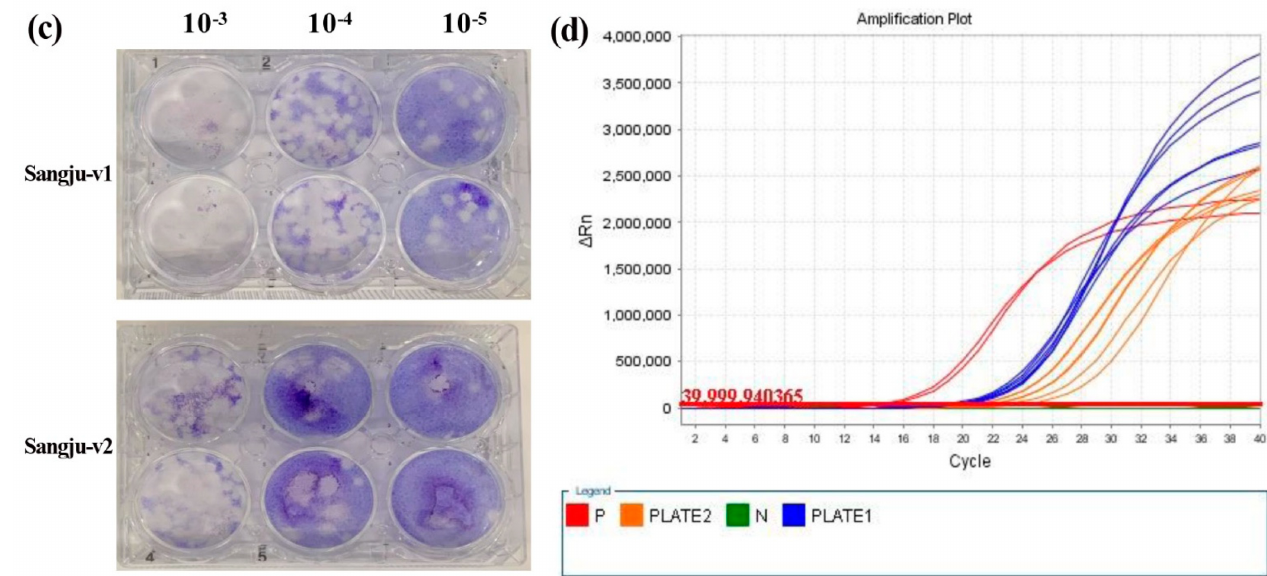
Figure 4. Results of Japanese encephalitis virus isolation: ( a ) Control C6/36 cells and ( b ) C6/36 cells 4 days after infection with positive mosquito sample showing cytopathic effects (200 × magnification). ( c ) Plaque phenotypes in BHK-21 cells. ( d ) Amplification curve of isolated Japanese encephalitis virus. P: positive sample; Plate1: Sangju-v1; Plate 2: Sangju-v2; N: negative sample.